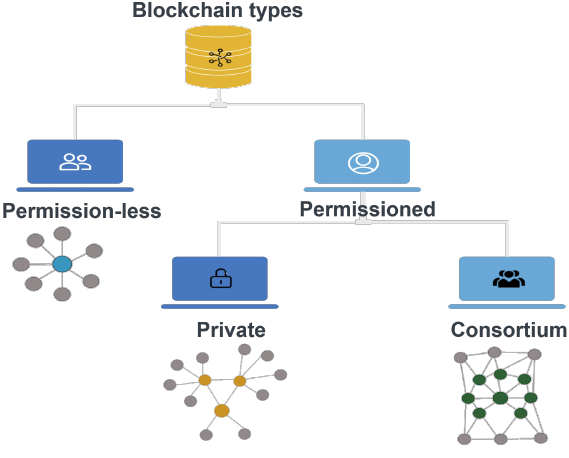
Figure 6. Hierarchy of